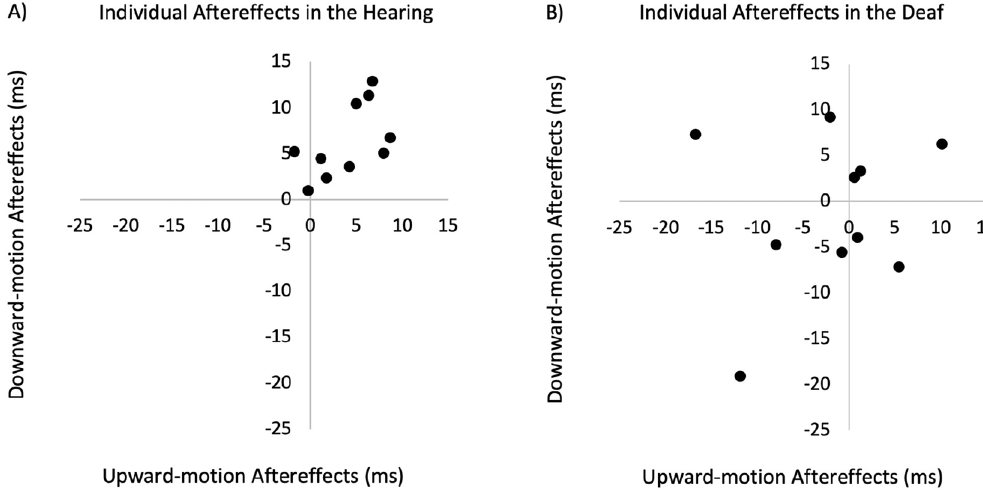
Figure 5. Scatter plots showing individual visual-to-tactile aftereffects in hearing (Panel A ) and deaf (Panel B ) group. The x-axis represents upward-motion aftereffect (upward-adaptation PSE-baseline PSE), and the y-axis plots the downward-motion aftereffect (baseline PSE-downward-adaptation PSE). The unit is ms of tactile ISO. Note that both upward-motion and downward-motion aftereffects plotted here are expected to be positive